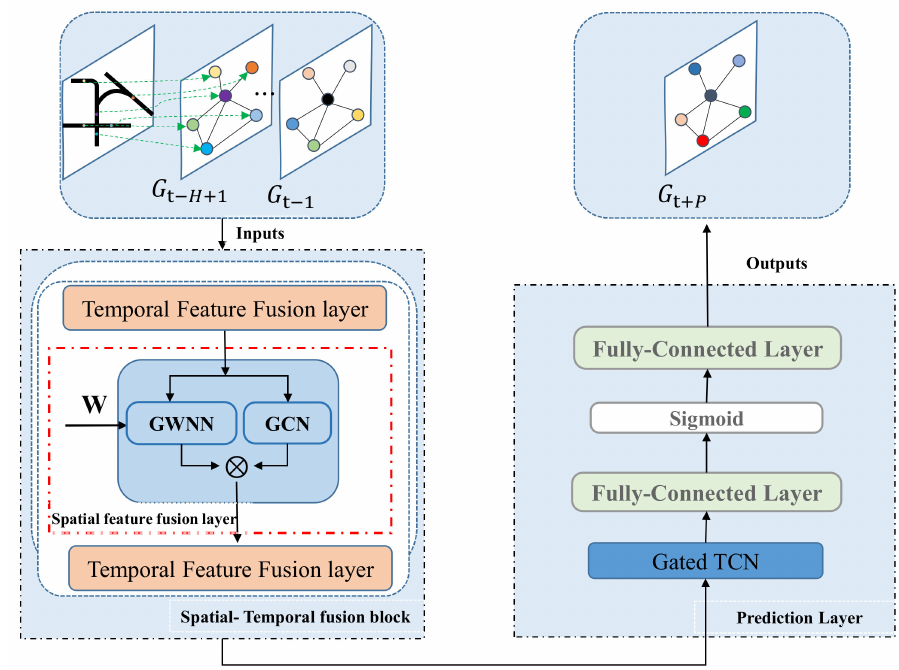
Figure 2. Overall Architecture of the STAGWNN